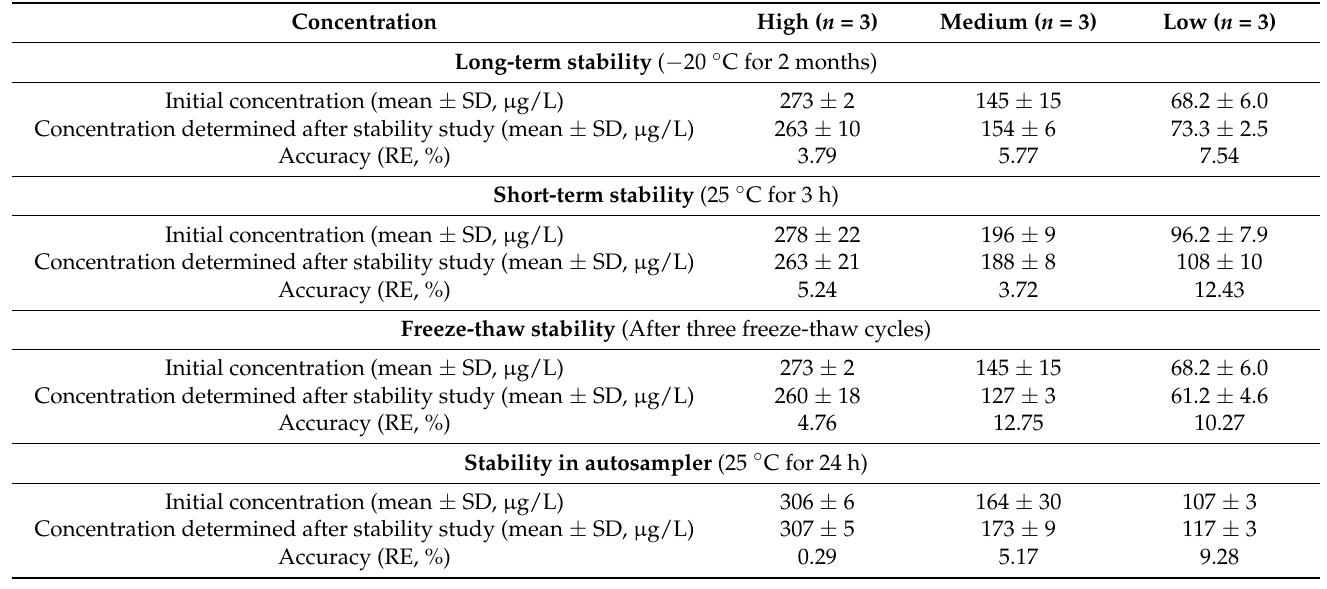
Table 3. The stability of iodine in urine samples under different conditions.